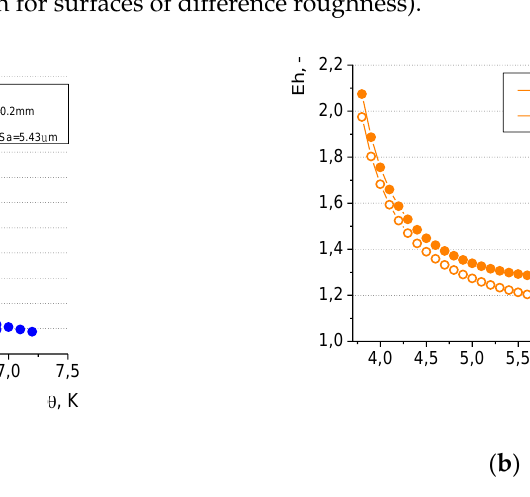
Figure 21. Enhancement ratio for ( a ) water and ( b ) ethyl alcohol.